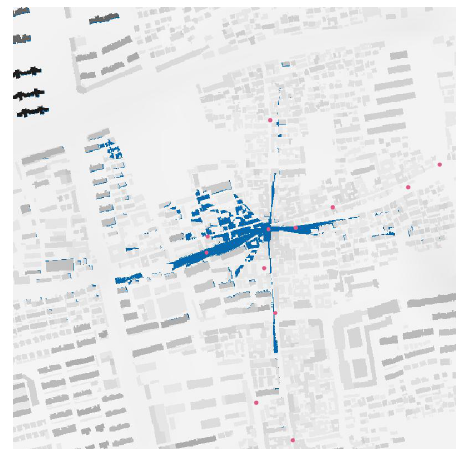
Figure 6 . The Viewshed from Hongfu Bridge in blue